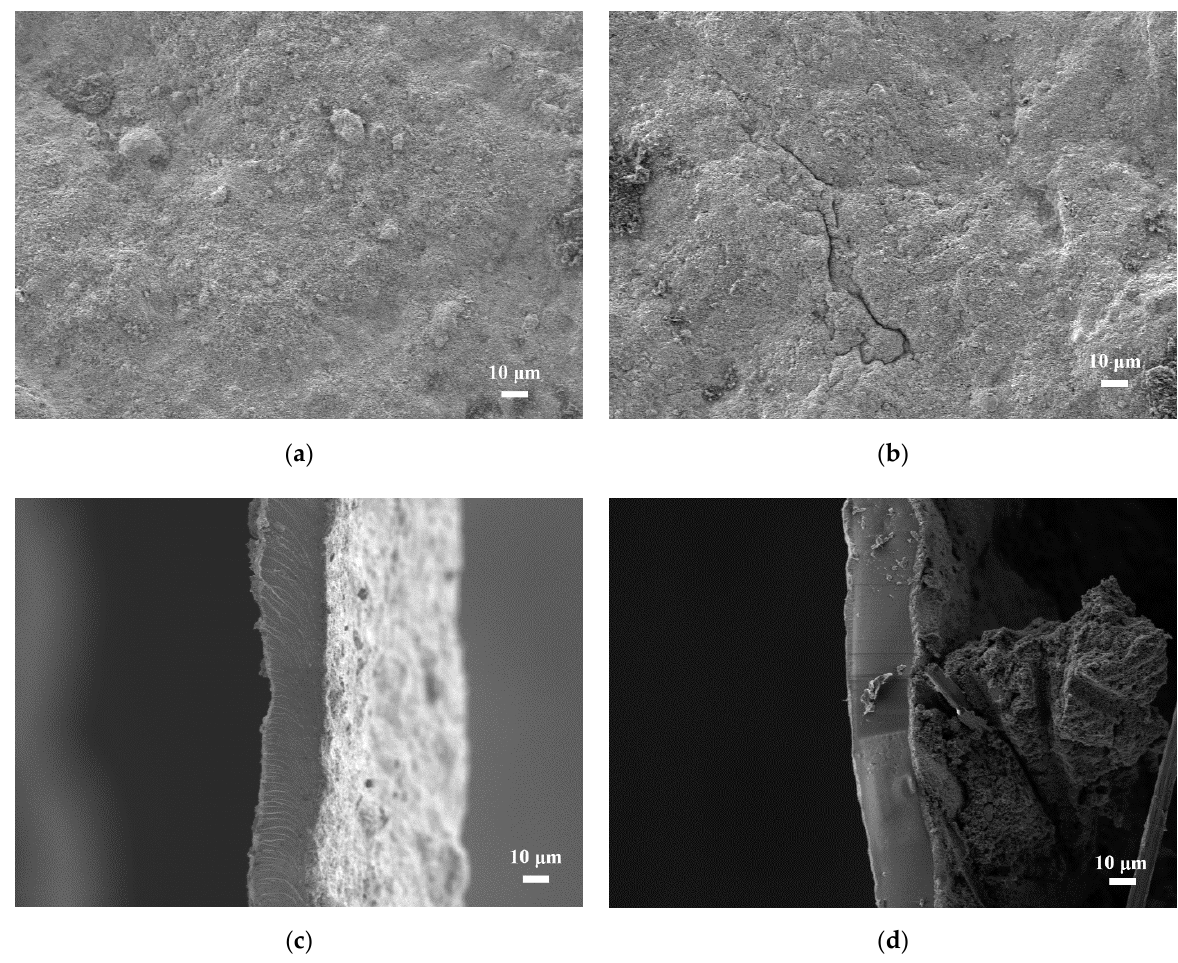
Figure 9. Surface and cross-sectional SEM images after 30 freeze/thaw cycles for: ( a ) CL of cell-4; ( b ) CL of cell-1; ( c ) cross-section of fresh MEA; and ( d ) cross-section of cell-1 .